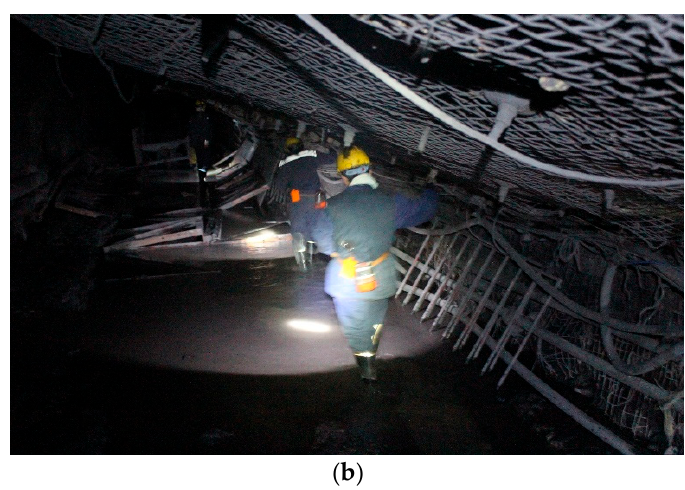
Figure 2. Tunnel arrangement: ( a ) Roadway design location of Wu 9,10 working face; ( b ) Image of gas-drainage roadway.